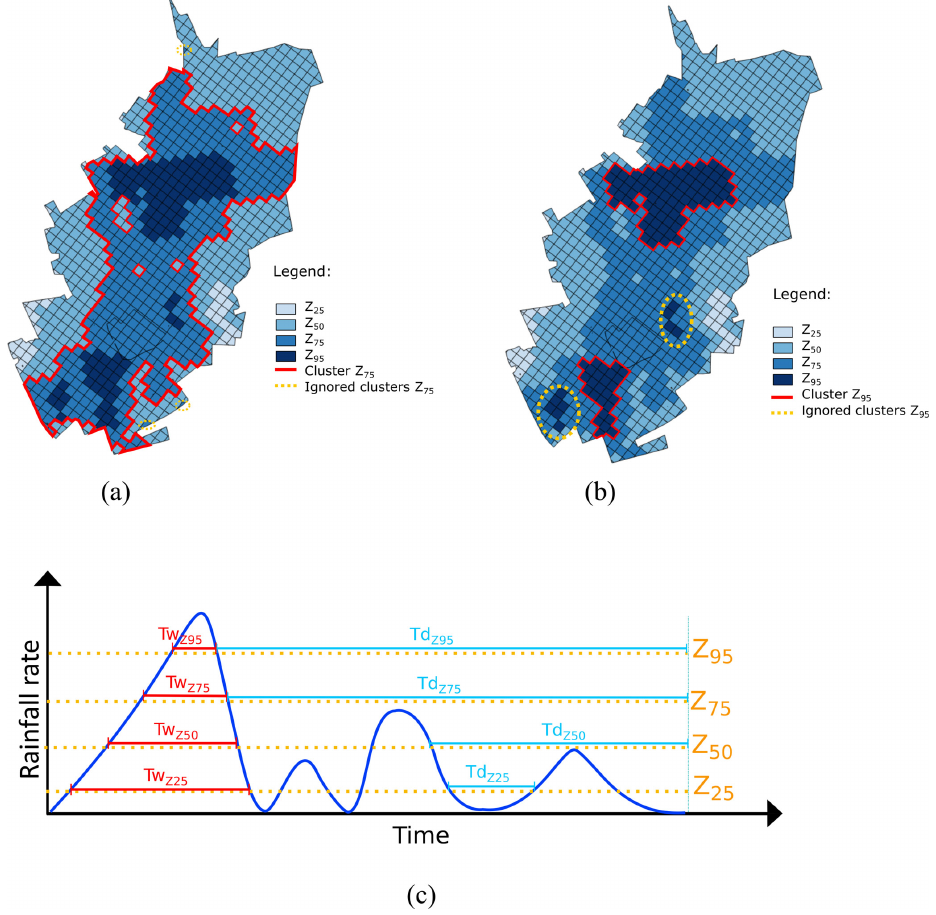
Figure 2. Illustration of rainfall cluster classification. Different colours represent different rainfall thresholds. The pixels above the same threshold are used to estimate the percentage of coverage above a certain threshold. The red line encloses the clusters above threshold Z 25 and Z 95 in (a) and (b) respectively. Single isolated pixels and small clusters (yellow dotted circles) are ignored. (c) Schematic representation of maximum wet period T w (red) and maximum dry period T d (light blue) for a pixel, for each Z Z